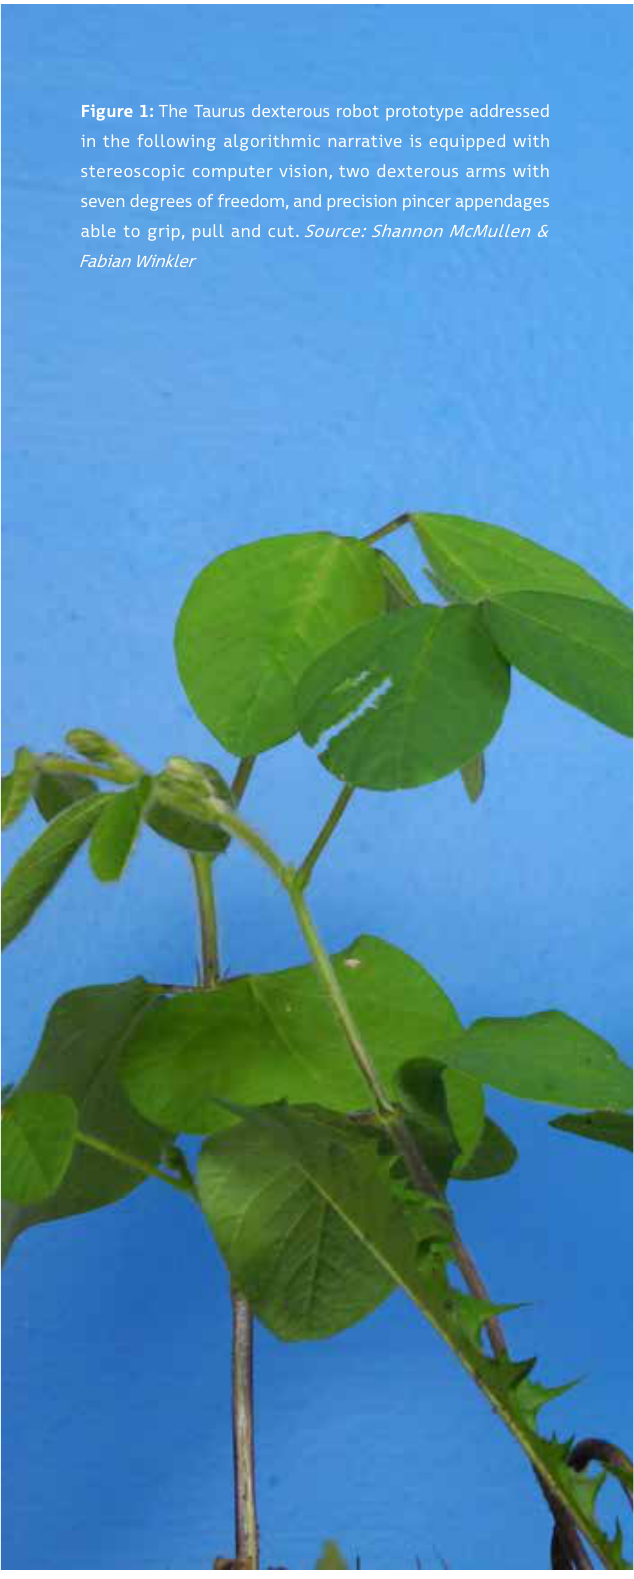
Figure 1: The Taurus dexterous robot prototype addressed in the following algorithmic narrative is equipped with stereoscopic computer vision, two dexterous arms with seven degrees of freedom, and precision pincer appendages able to grip, pull and cut. Source: Shannon McMullen